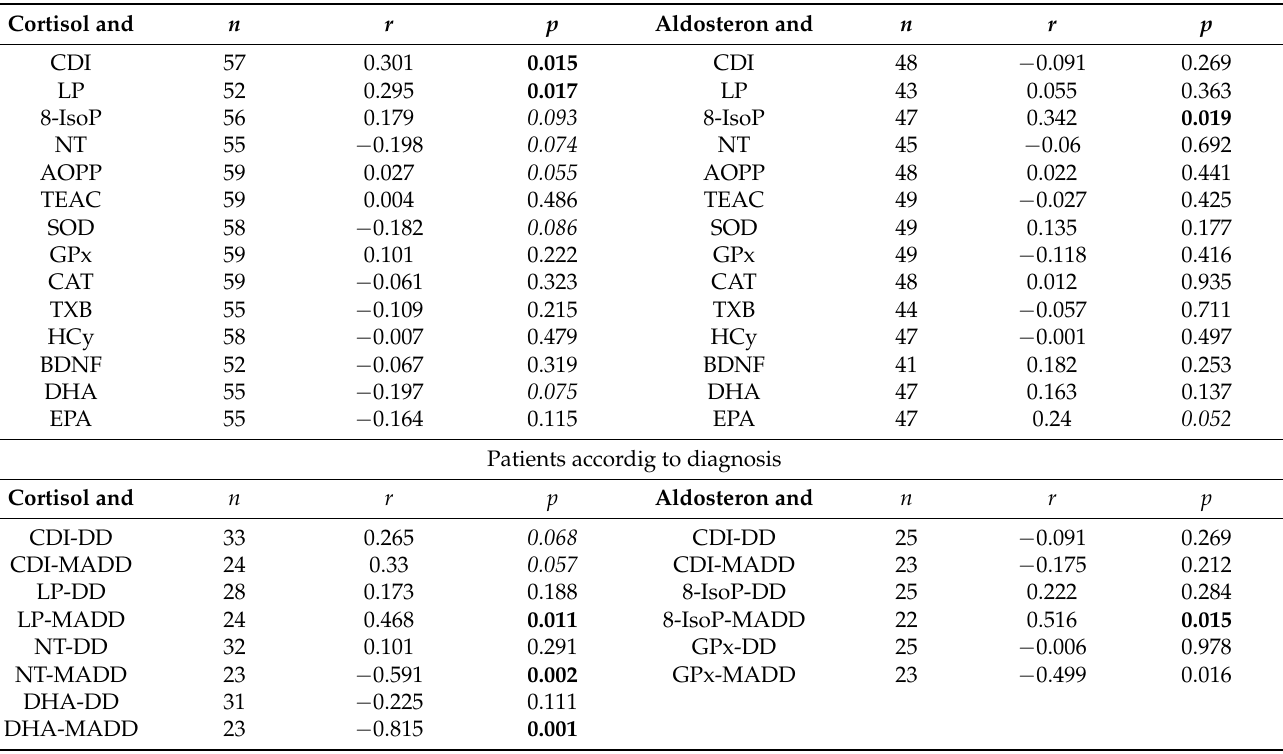
Table 1. Correlations between morning cortisol or aldosterone and parameters in the patients at the baseline (week